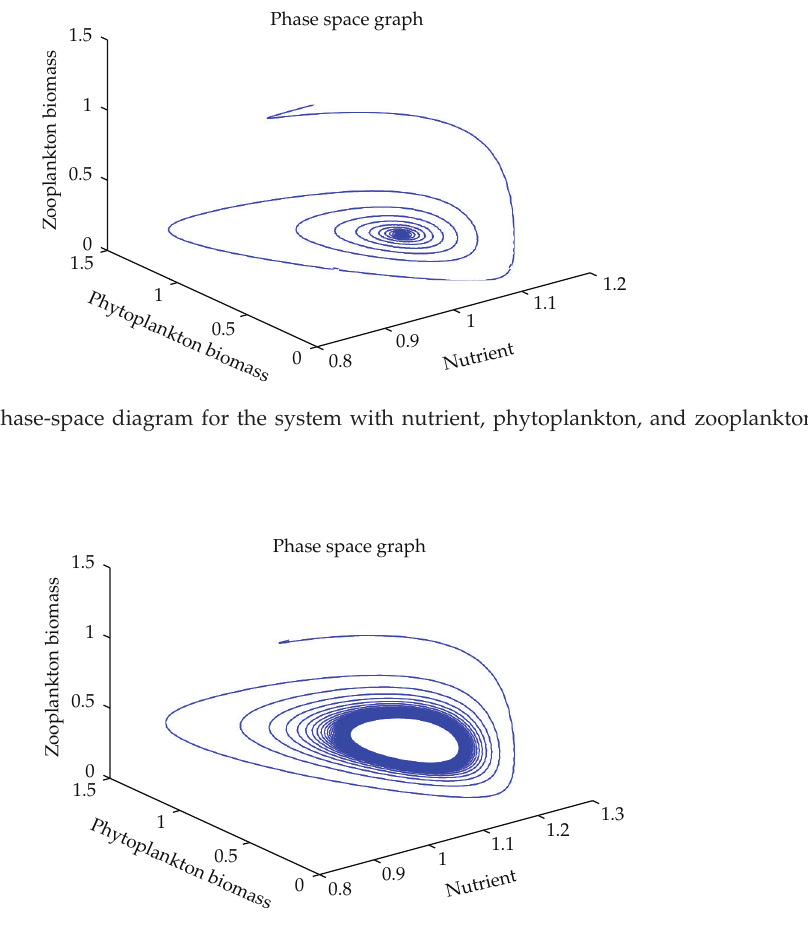
Figure 8: Phase-space diagram for nutrient, phytoplankton, and zooplankton at α (cid:7) 1 . 1775, α 1 (cid:7) 0 .